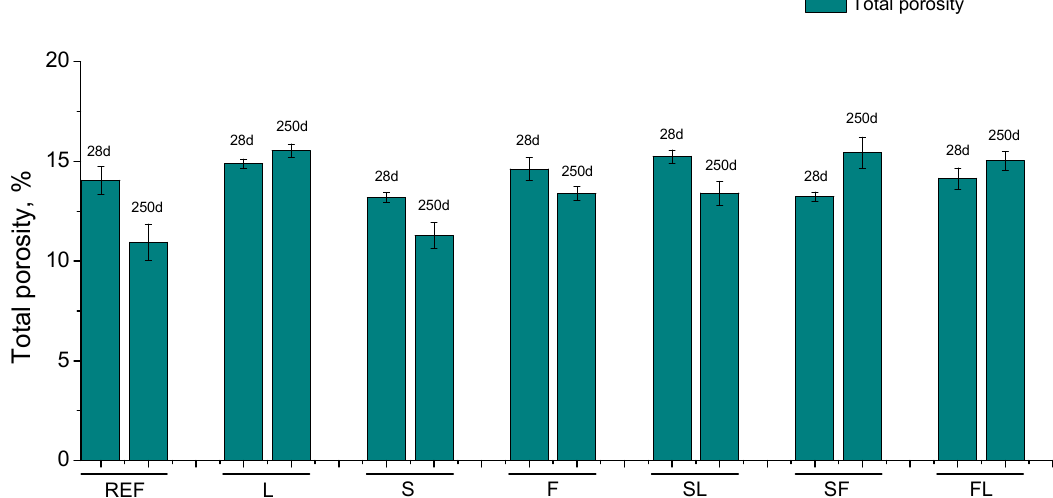
Figure 1. Results of total porosity for the studied mortars. In this figure and in the next figures, the mean value of the parameter obtained for each type of mortar is represented. The error bars represent the standard deviation.